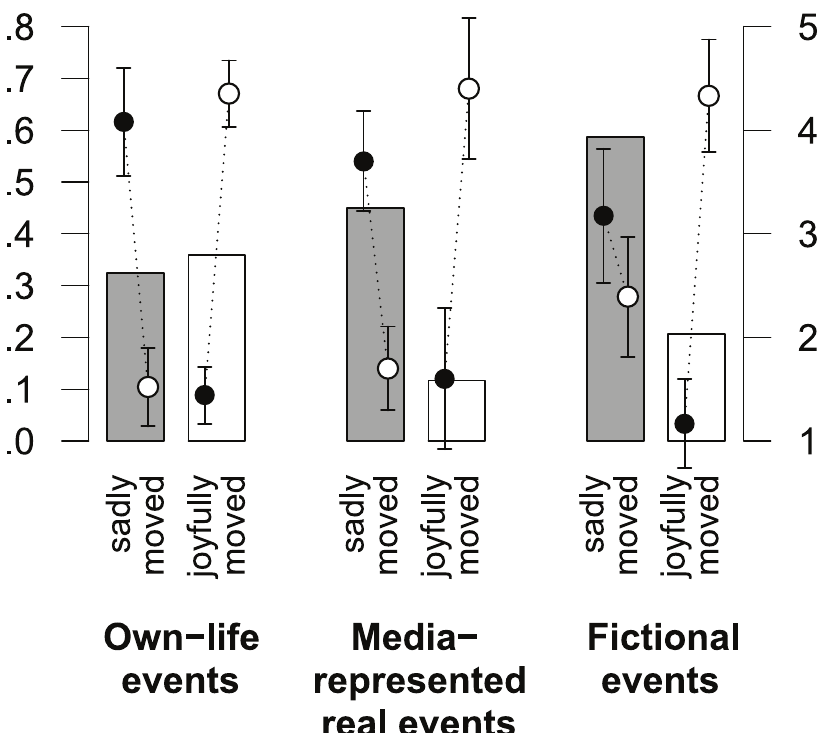
Fig 3. Frequencies of sadly and joyfully moving events and the means of their negative and positive affects. The percentages of participants who reportedly experienced sadness or joy in a moving situation (grey and white bars, respectively; left axis) are depicted for each group. In addition, the means of the negative and positive valence ratings (black and white points, respectively; right axis) with 95% confidence intervals are depicted separately for sadly and joyfully moving episodes in each